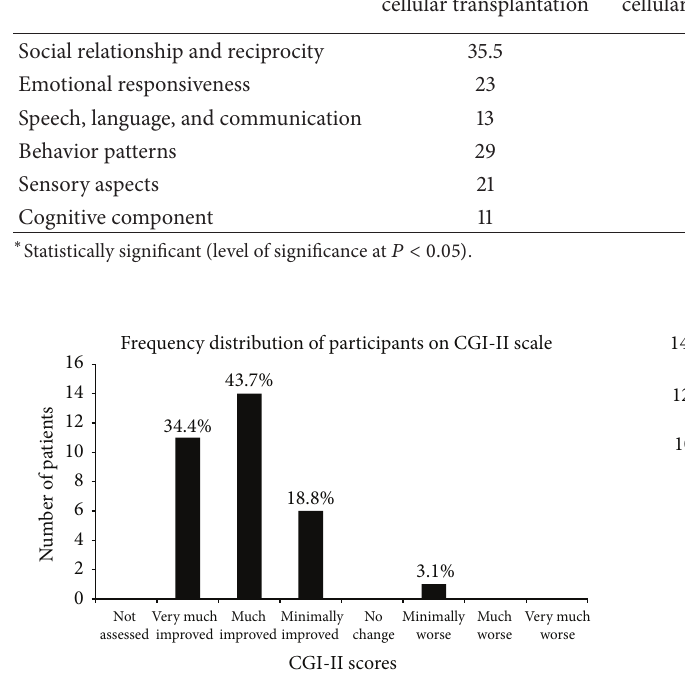
Figure 1: Frequency distribution of participants on CGI-II scale.